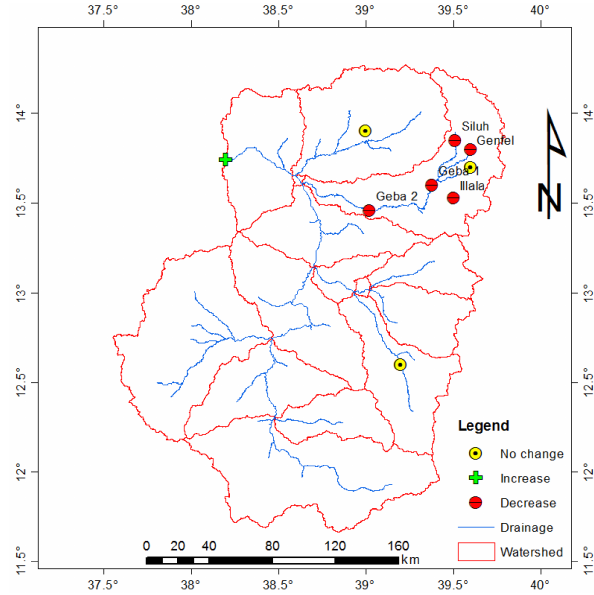
Figure 5. Location of streamflow stations with increasing ( + ), de- creasing ( − ) and no-change (0) trends on dry season